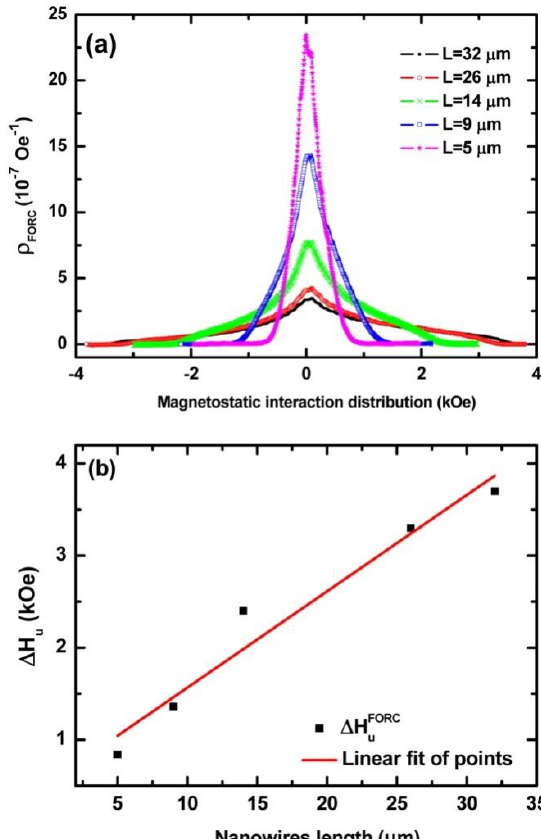
Fig. 7. (a) Magnetostatic interaction distribution for different samples. (b) Magnetostatic interaction field as a function of NWs length.